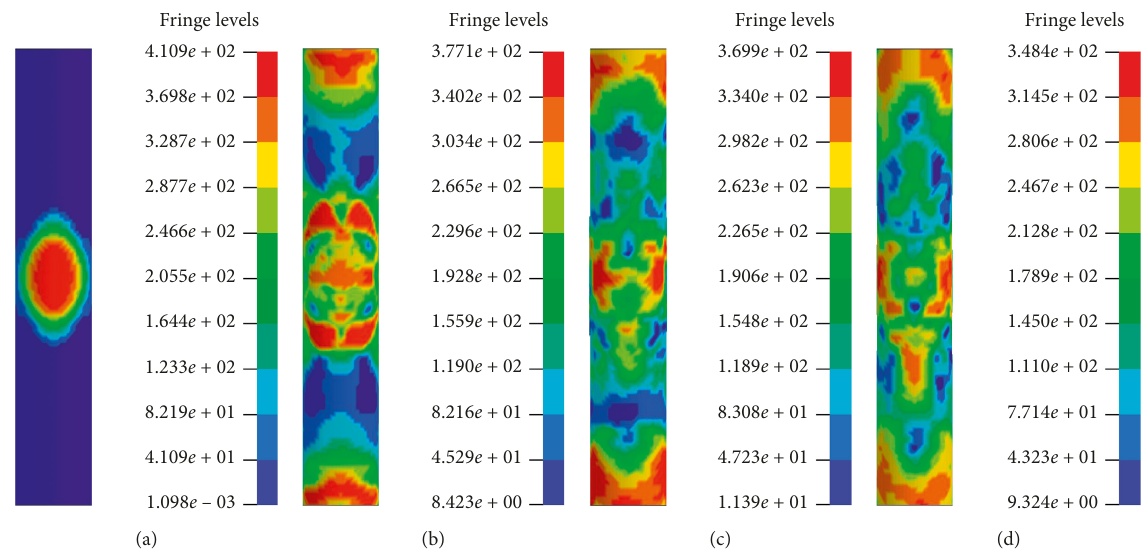
Figure 16: Effective stress contours of the steel tube at different time periods (front view): (a) t � 0.3ms, (b) t � 1 ms, (c) t � 2ms, and (d) t � 3ms.